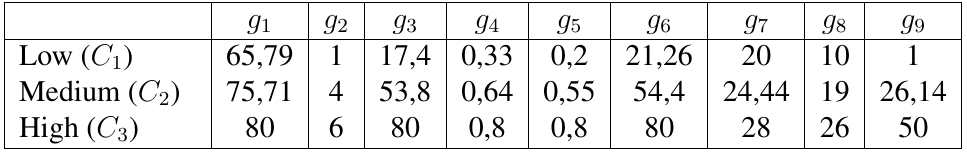
for each criterion g ij